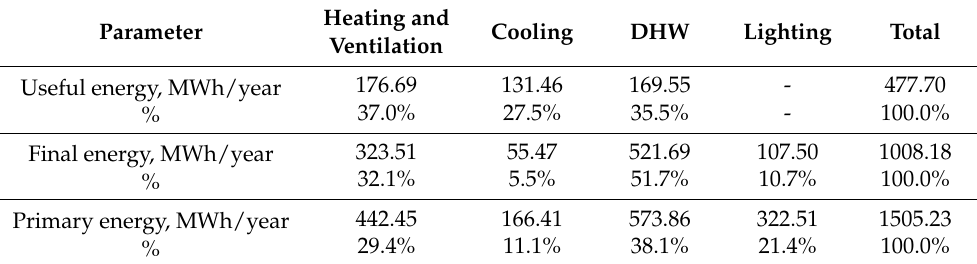
Figure 6. Comparison of annual energy demand by simulation model and actual data. Table 6. Heat demand calculations after replacing air handling units—variant 1.